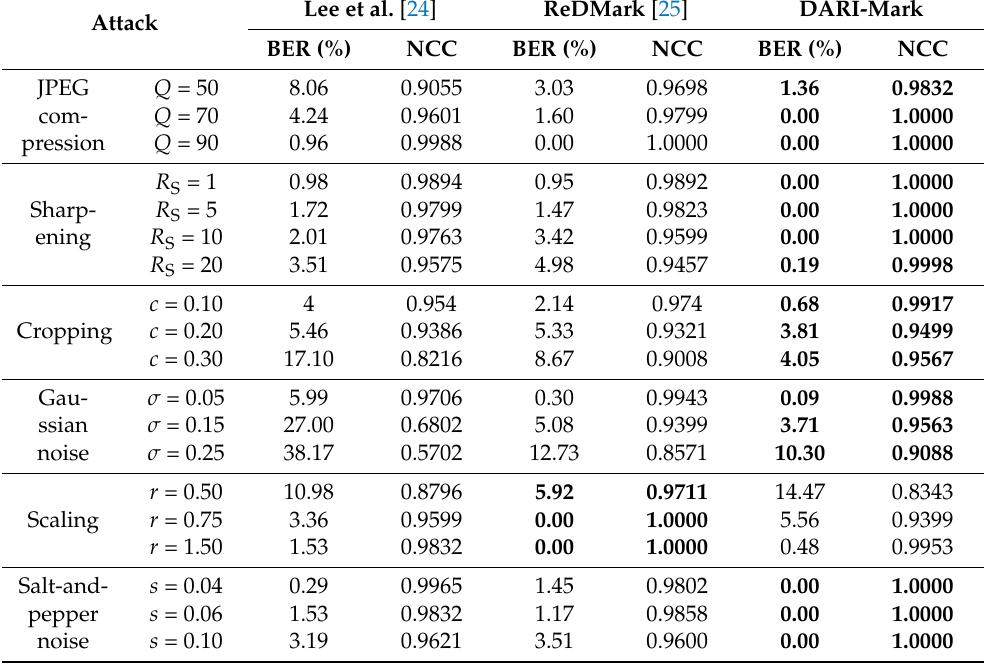
Table 3. BER and NCC comparison results of three methods under multiple